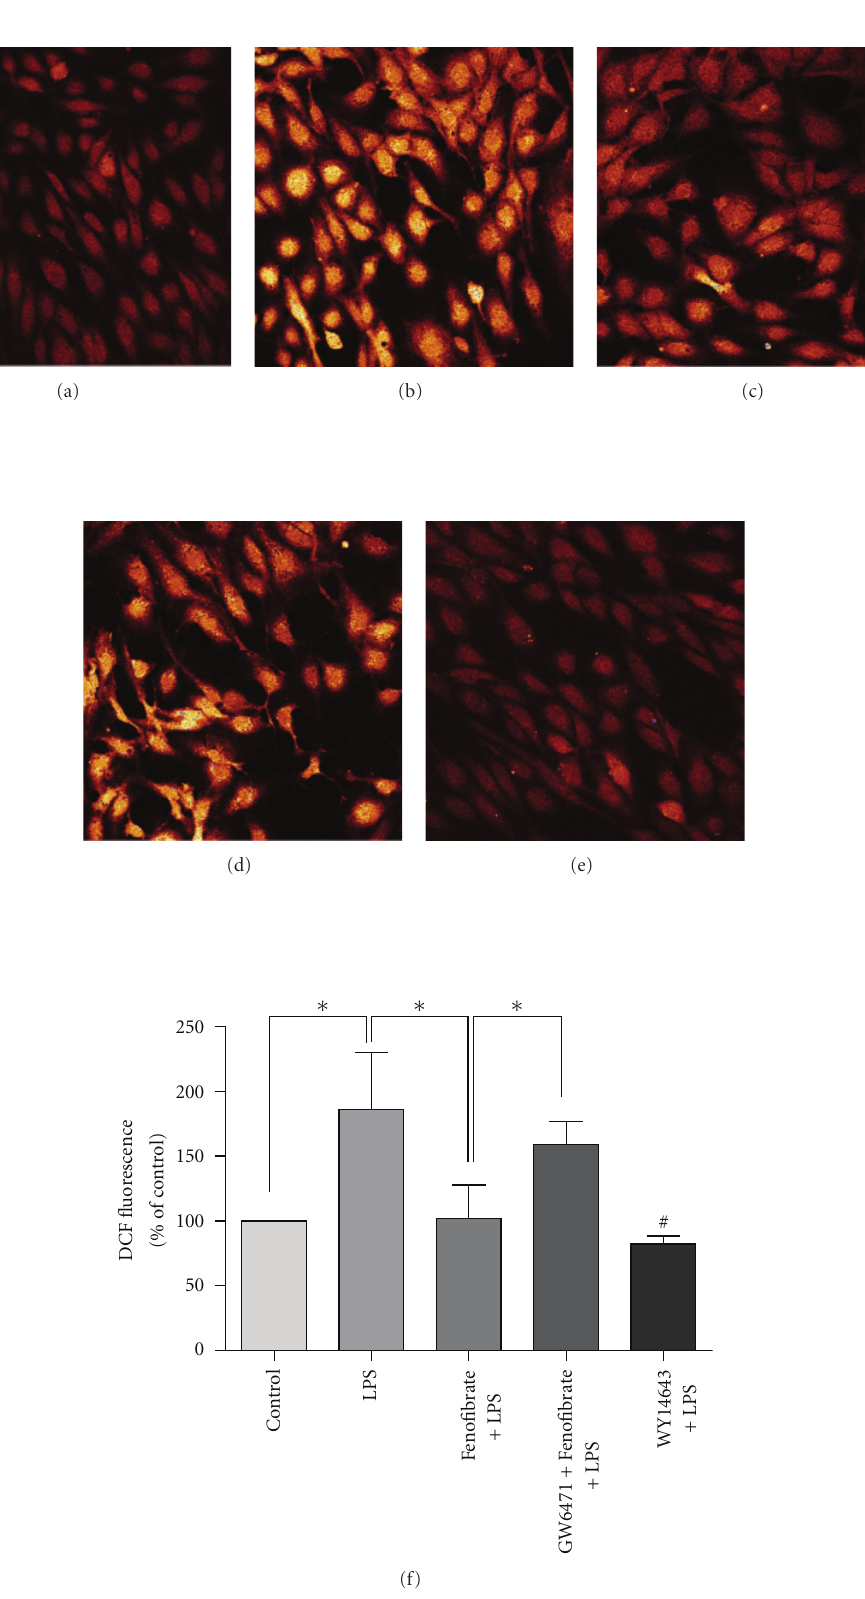
Figure 2: E ff ect of fenofibrate and related compounds on ROS formation in cultured endothelial cells. DCFH-DA (20umol/L) was added to monitor intracellular ROS production with a confocal laser scanning microscope (Leica). (a) Control group; (b) LPS group; (c) fenofibrate+LPS; (d) GW6471 +fenofibrate+LPS; (e) WY14643 +LPS; (f) statistical graph. Values are expressed as means ± SD; n = 6. ∗ P < 0 . 05; # P < 0 . 05 versus LPS